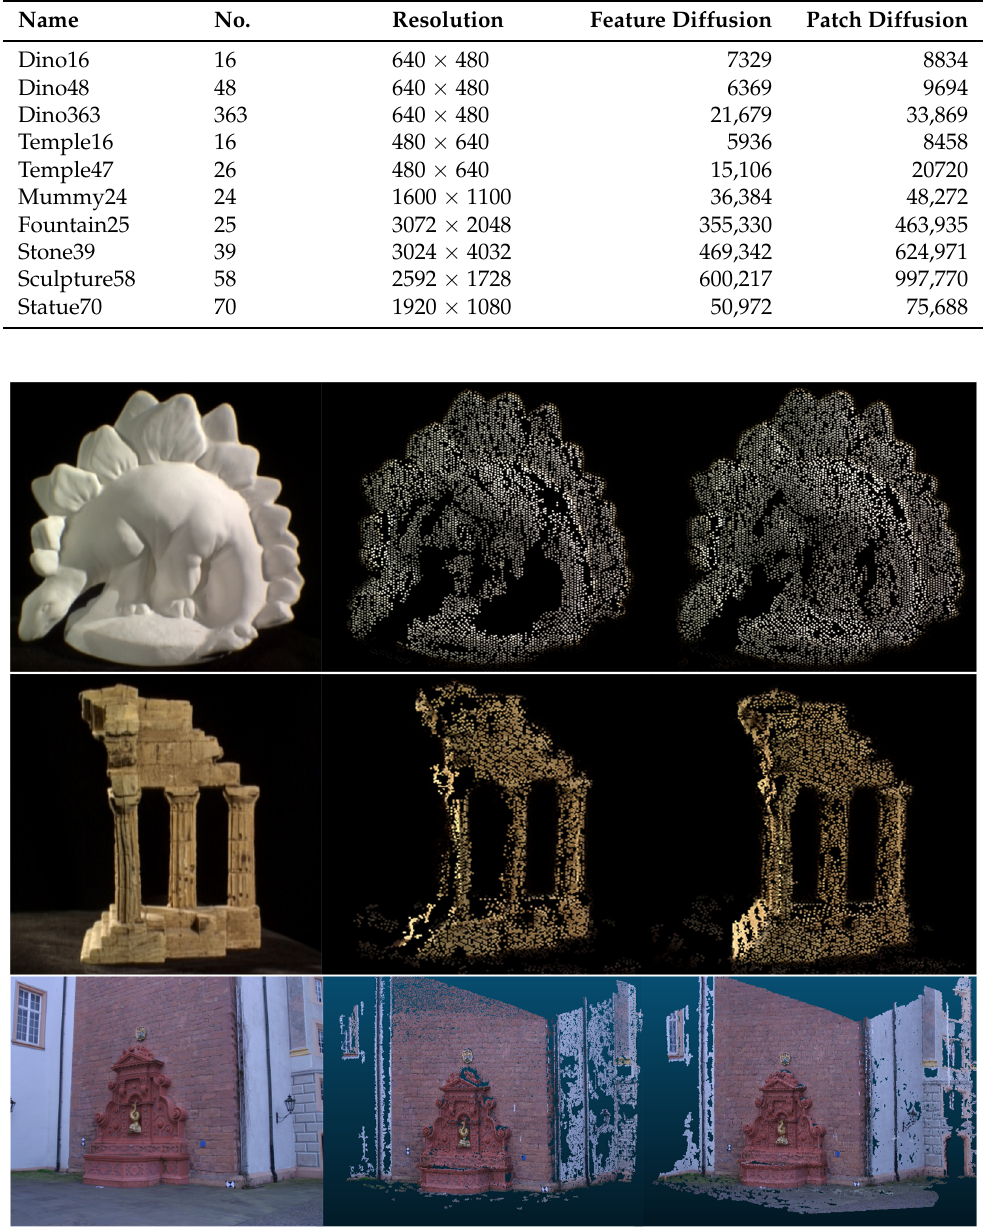
Figure 4. Illustration of the reconstruction result of proposed dense diffusion algorithm on three datasets, “Dino16”, “Temple16” and “Fountain25”. From left to right: sample of image sequence, feature diffusion results, patch diffusion